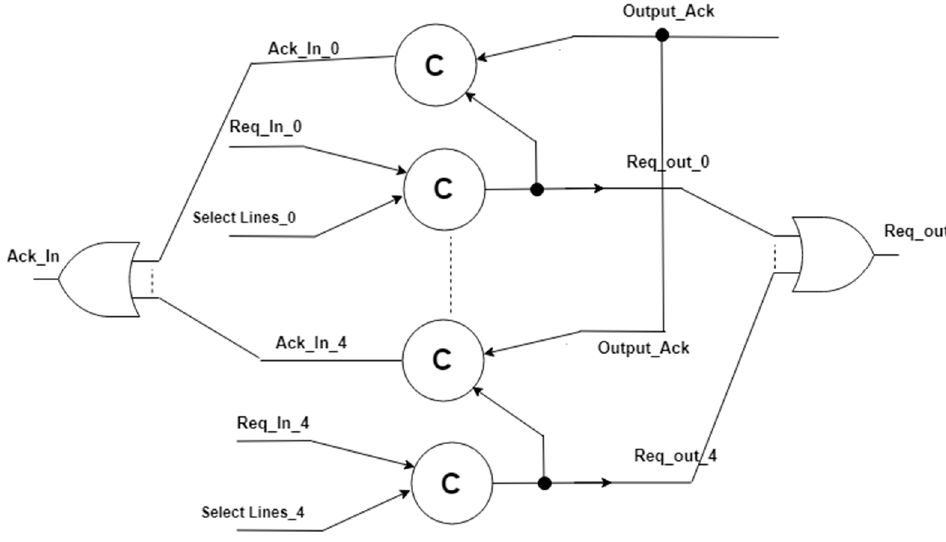
Figure 7. Multiplexing stage utilized for routing the request and acknowledgment